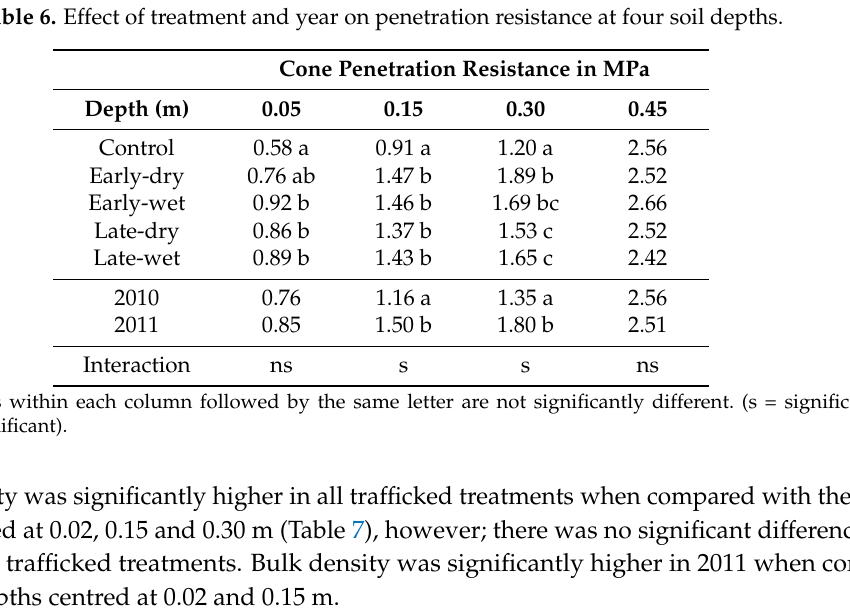
Table 6. Effect of treatment and year on penetration resistance at four soil depths.